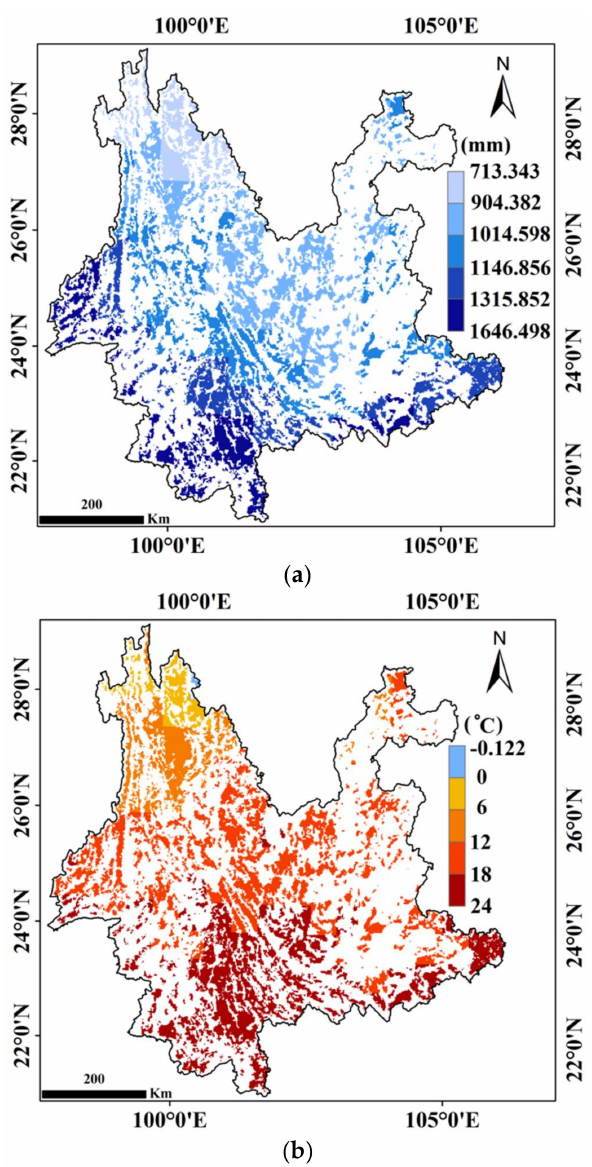
Figure 2. The spatial distribution of ( a ) the mean annual precipitation and ( b ) the mean annual temperature from 2001–2014. These data sets (CRU, the Climatic Research Unit, TS 3.23) were obtained from the Center for Environmental Data Analysis [45], which forms the basis of CRU SPEIbase (v2.4)